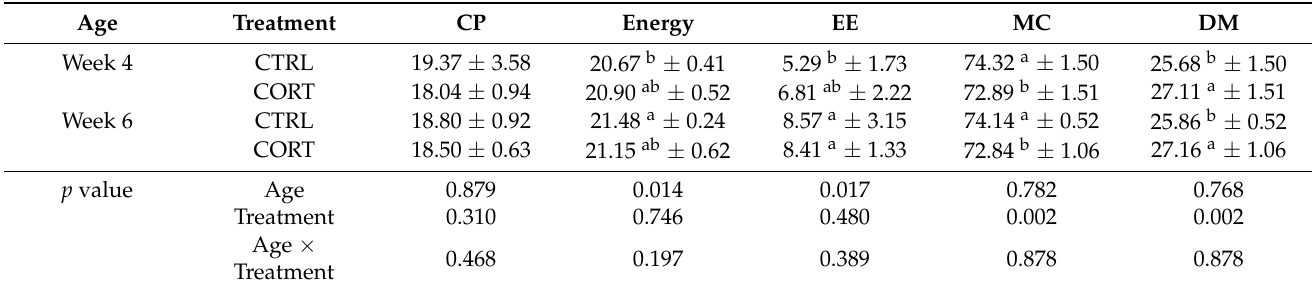
Table 9. Effect of corticosterone administration and age on biochemical compositions ( ± SD) of CORT chicken meat versus